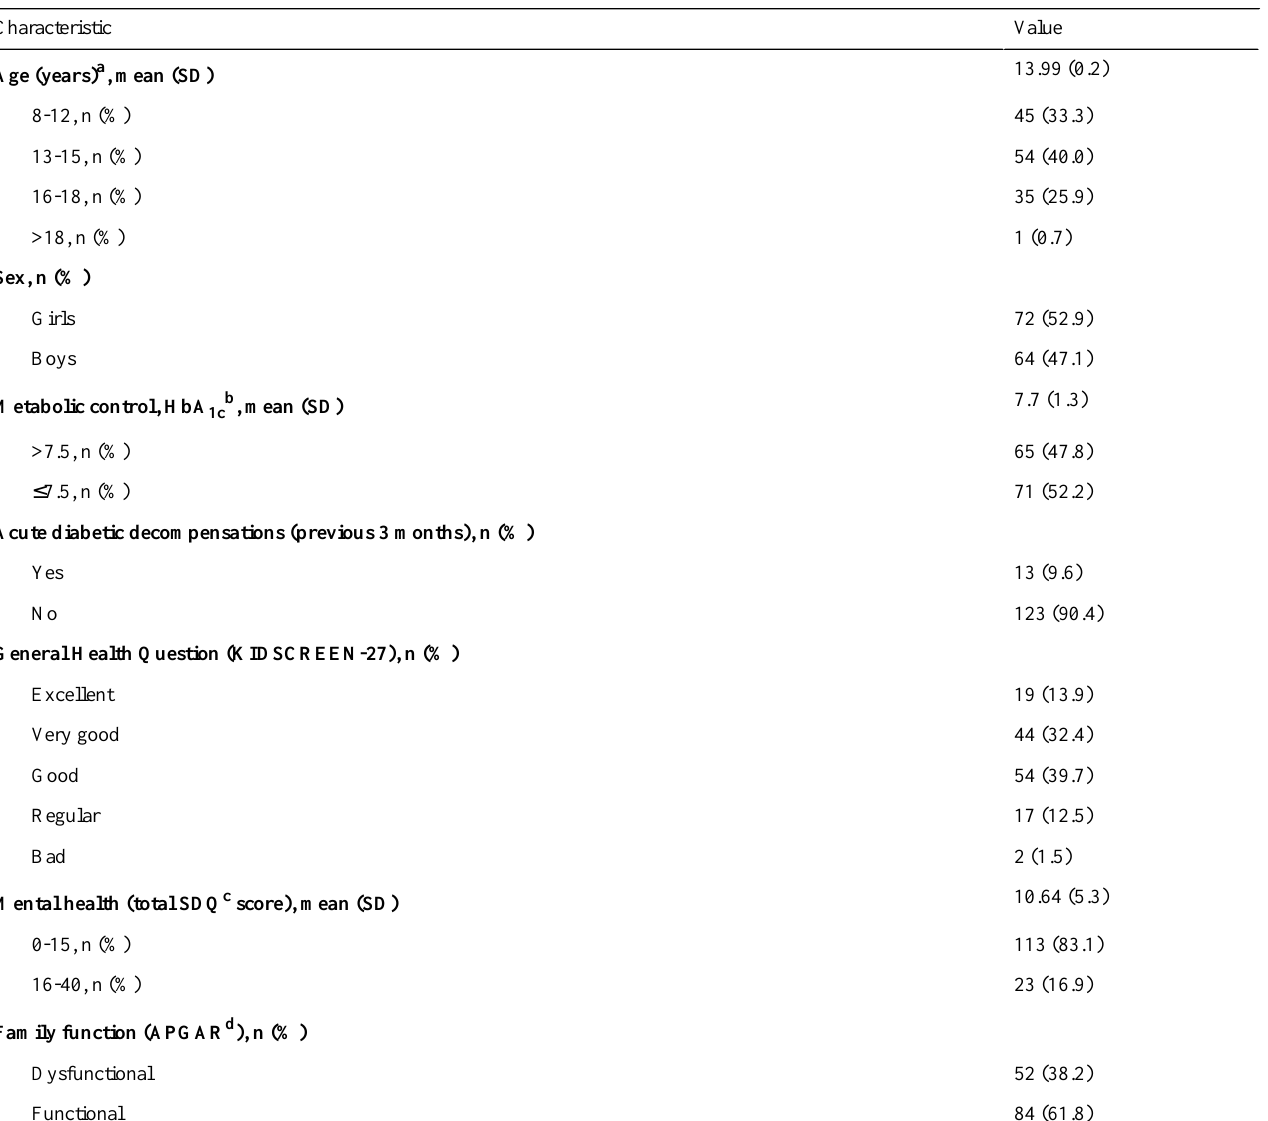
Table 1. Demographic and clinical characteristics of the participants